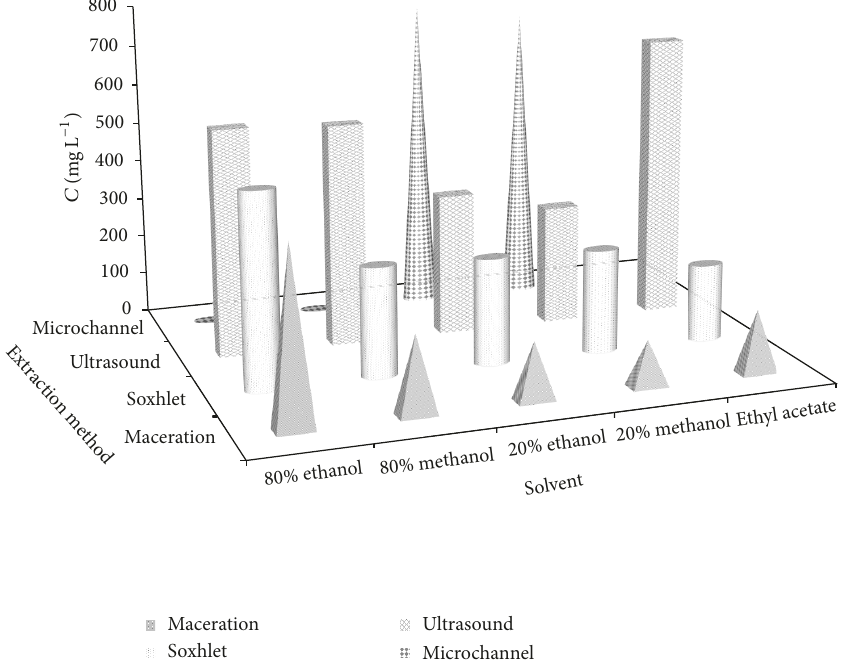
Figure 2: Effects of different solvents on the extraction oleuropein for maceration, soxhlet, ultrasound, and microchannel.